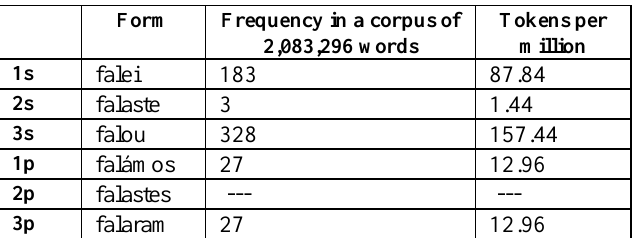
Table XV. Frequency of preterit-tense forms in spoken Portuguese, according to Davies and Ferreira (2006-) Form Frequency in a corpus of 2,083,296